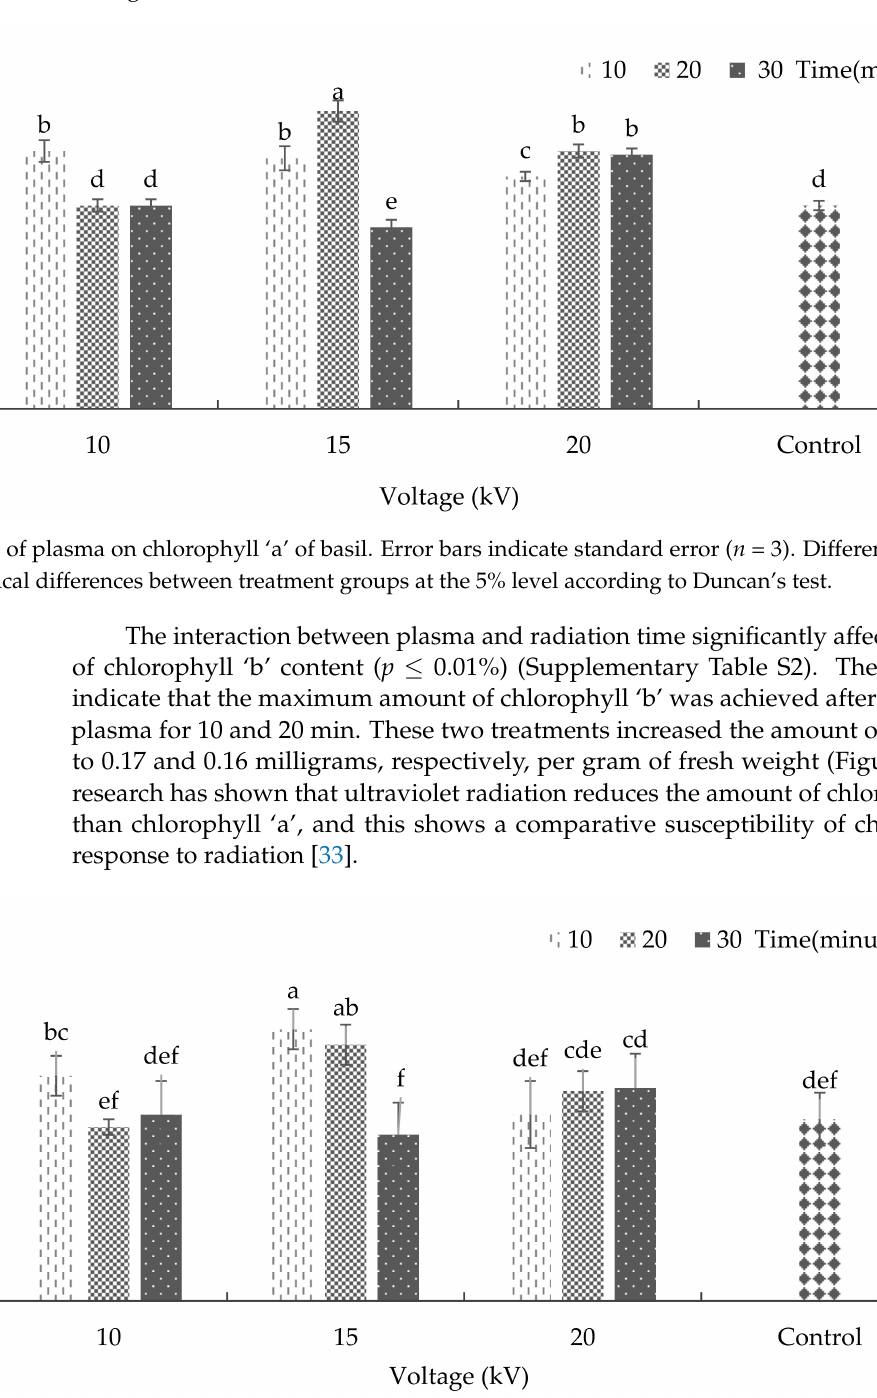
Figure 4. The effects of plasma on chlorophyll ‘b’ of basil. Error bars indicate standard error ( n = 3). Different lowercase letters denote statistical differences between treatment groups at the 5% level according to Duncan’s